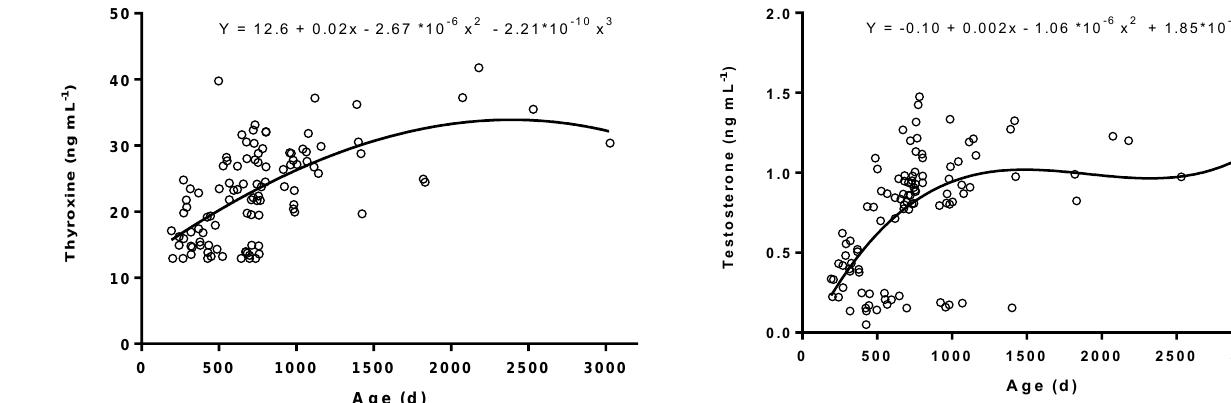
Figure 1. Age-related variations in plasma thyroxine concentra- tions in male Murrah buffaloes ( n = 103).